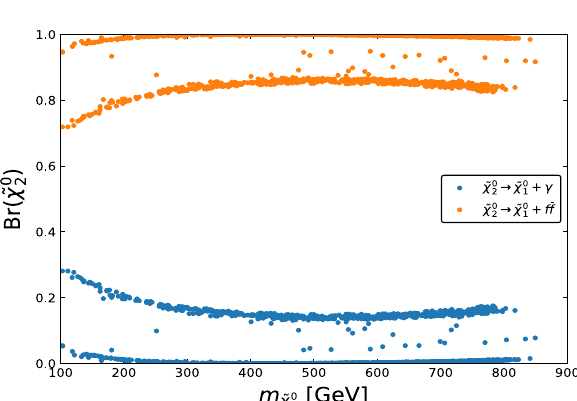
+ jets j → E miss T 1